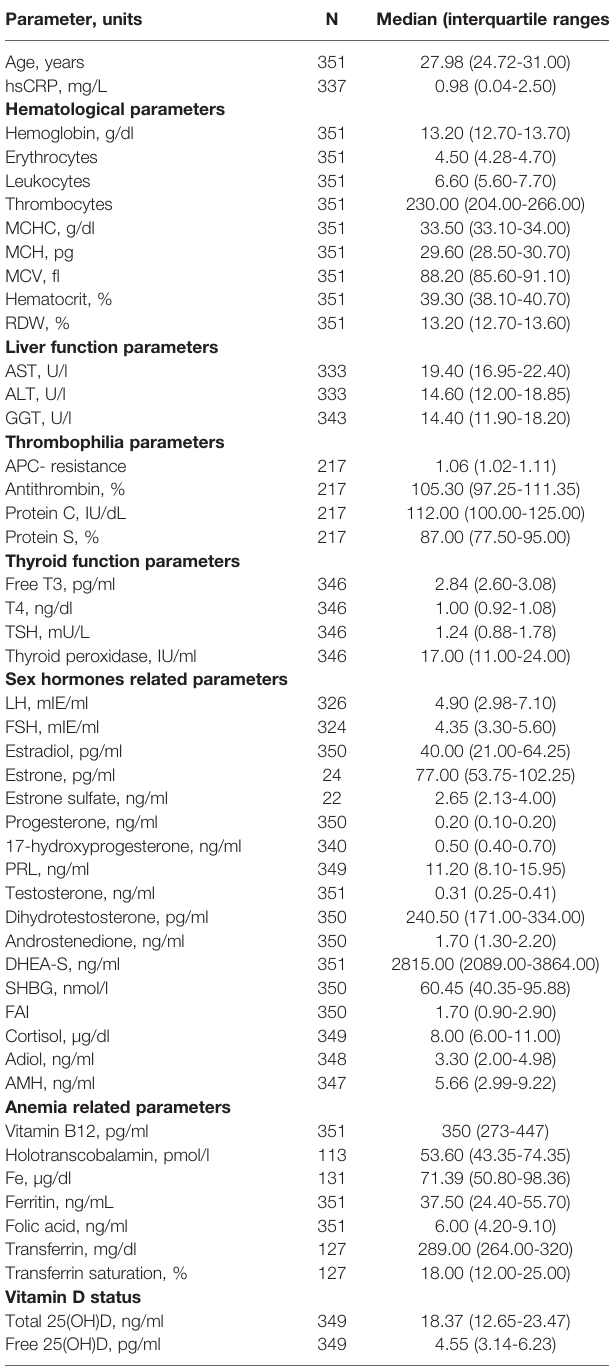
TABLE 1 | Main characteristics of the 351 healthy women (women without any abnormal laboratory